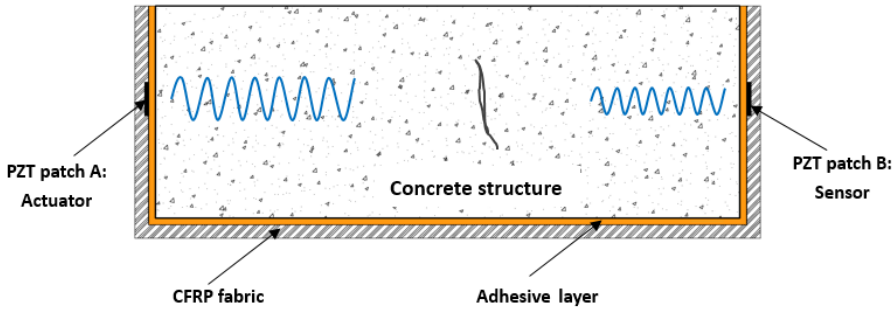
Figure 2. The damage detection principle of the SCFRP fabric.